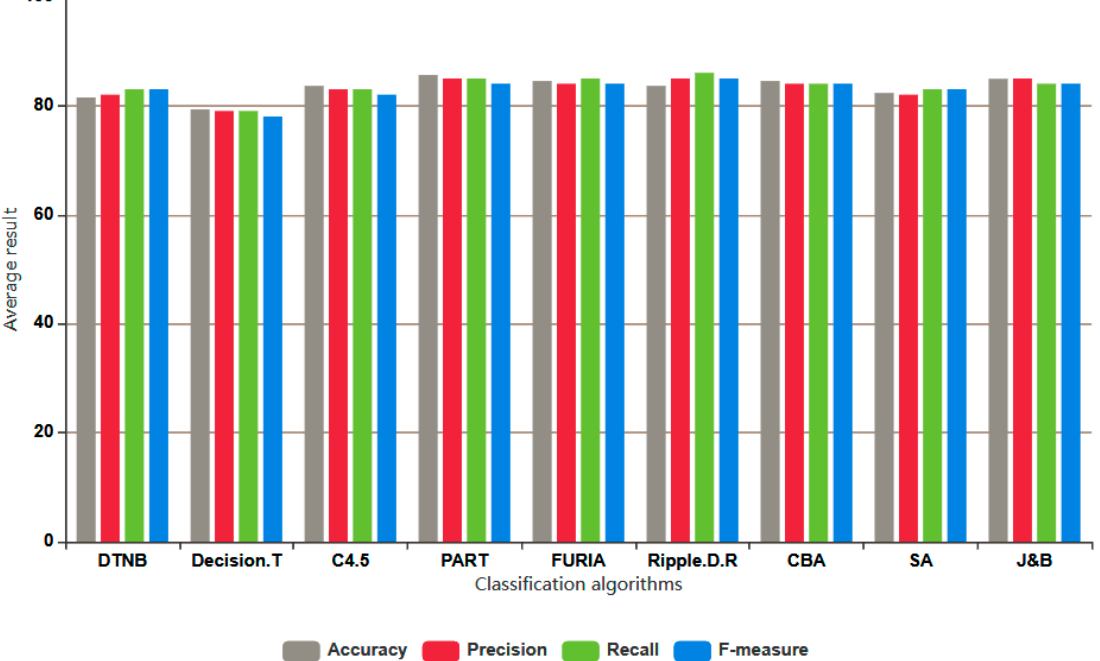
Figure 3. Comparison of the J&B classifier on Accuracy, Precision, Recall and F-measure.